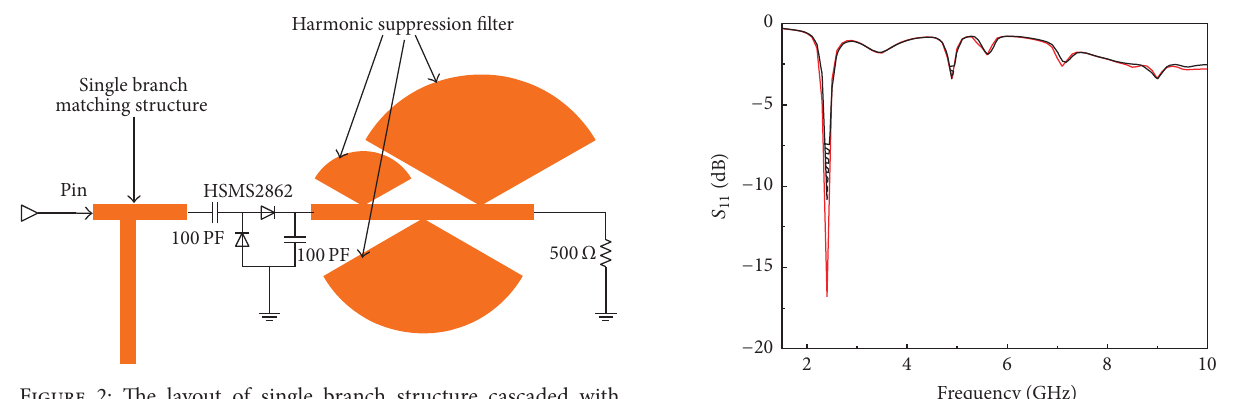
Figure 2: The layout of single branch structure cascaded with rectification circuit and fan-shaped filtering structure.